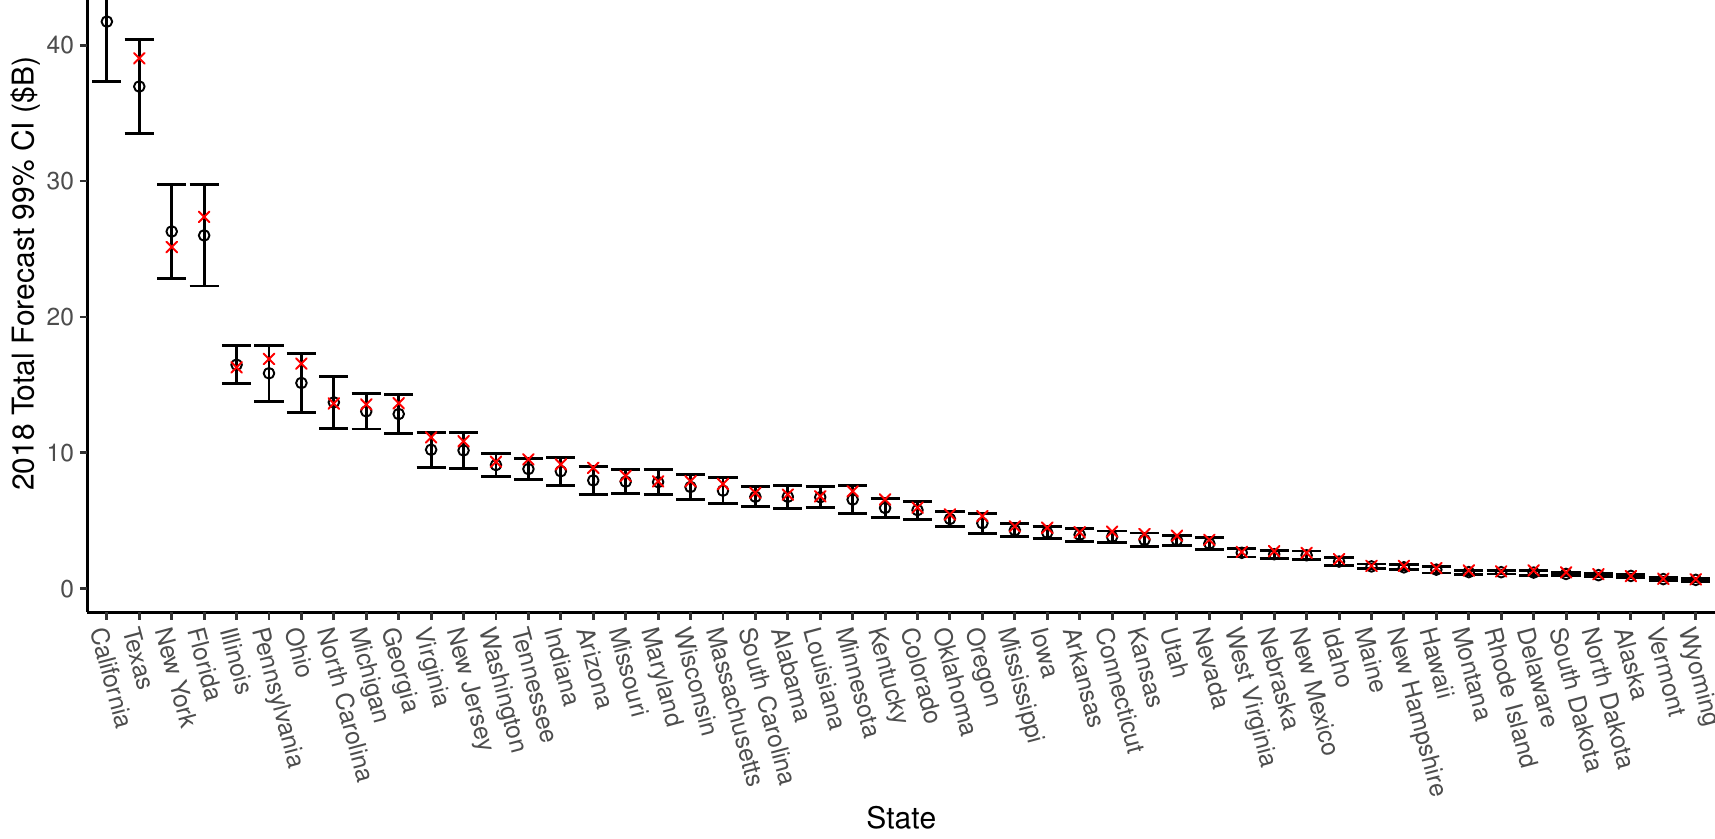
Figure 8. Side by side 99% prediction intervals by state for the forecast produced using damped Holt method as of 2018. The symbol (o) denotes the point estimate of the forecasted cost while the symbol (x) denotes the actual cost as computed using methodology of Section 2. Prediction intervals are arranged in descending order based on the magnitude of the point